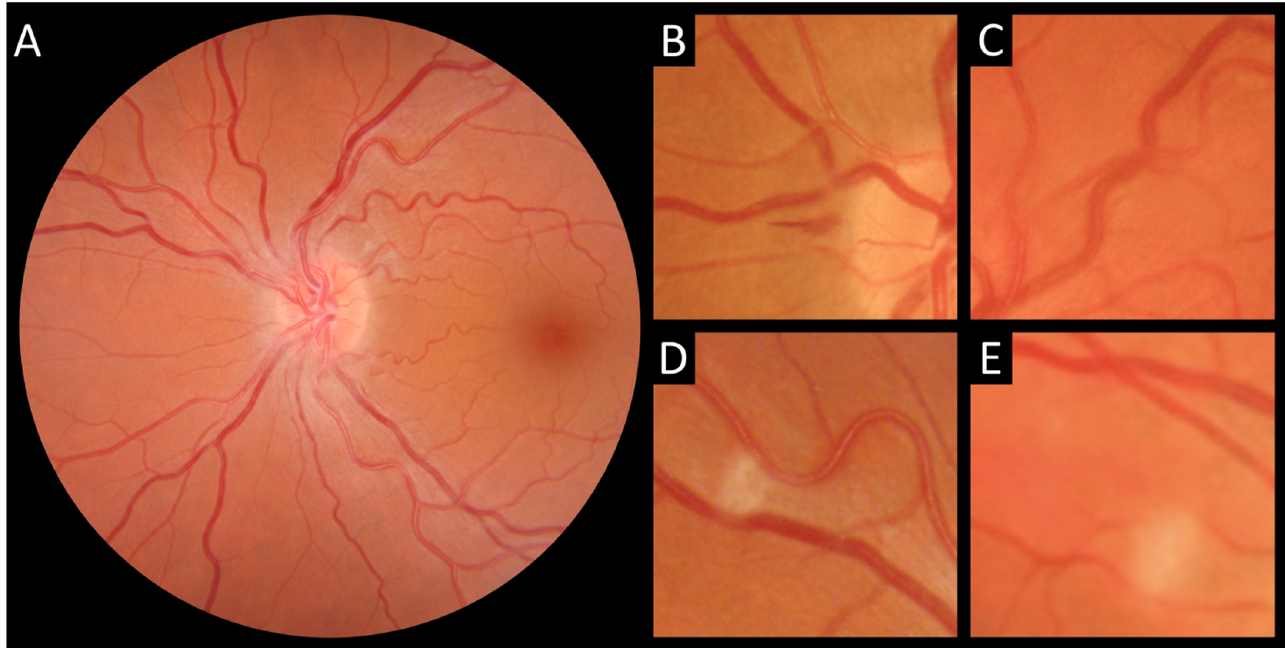
Figure 1. Signs of COVID-19 retinopathy. ( A ) Dilated and tortuous retinal vessels. ( B ) Retinal hemorrhage. ( C ) Dilated and tortuous vein. ( D , E ) Cotton wool spots. Table 2. Baseline characteristics based on the presence of COVID-19 retinopathy.